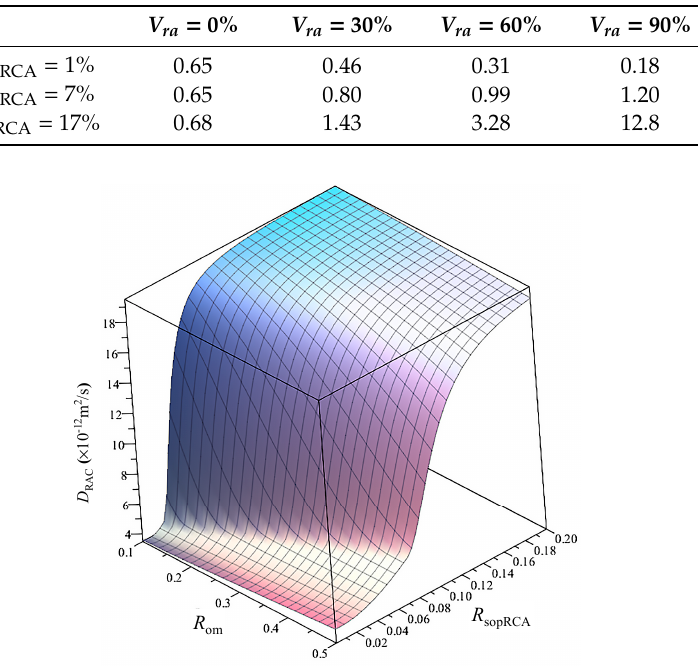
Figure 13. D RAC ( × 10 − 12 m 2 / s) changing with water absorption of RCA and old mortar content in Figure 13. D RAC (×10 − 12 m 2 /s) changing with water absorption of RCA and old mortar content in RCA.